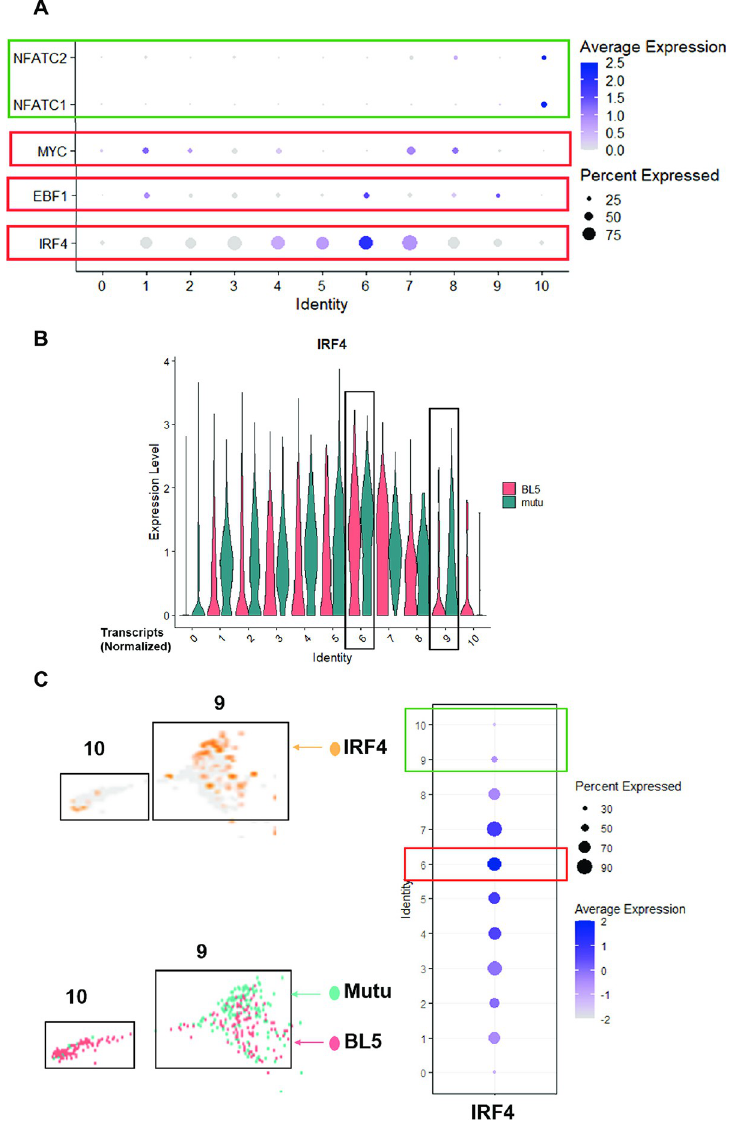
Fig 18. T2 LCLs have less IRF4 (Cluster 9) and more NFATc1 (Cluster 10) compared to latent cells, or T1 cells in Cluster 9. A. Dot plot presentation of NFATc1/c2 expression across all 11 cell clusters. B. Violin plot presentation of IRF4 expression in all 11 clusters shown separately for the BL5 and Mutu samples. C. Overlaid UMAP for expression of IRF4 in Cluster 9 and 10 split by sample type and DotPlot of IRF4 across all 11